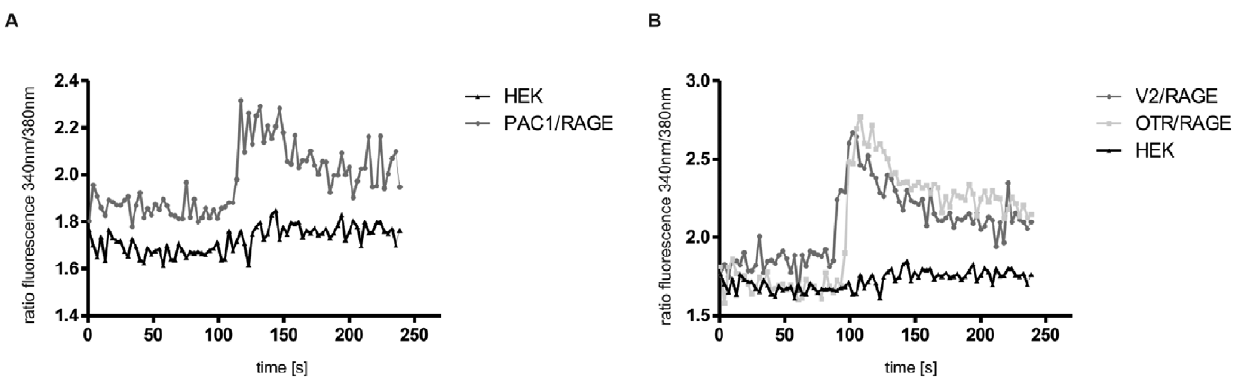
Figure 11. Measurement of intracellular calcium signaling. PAC1/RAGE (A), V2R/RAGE and OTR/RAGE cells (B) as well as HEK cells (A/B) were incubated for 30 min with 1,5 m M fura 2-AM. Then the cells were suspended and collected by centrifugation (0.4 g), after suspending cells in calcium buffer, measurements were performed with a spectrofluorometer. The respective agonists were applied to the cells after 100 s. As a negative control, either PACAP-27 or OT and AVP were added to HEK cells. Rising intracellular Ca 2 + levels are detected by an increase in the fluorescence ratio 340 nm/ 380 nm.